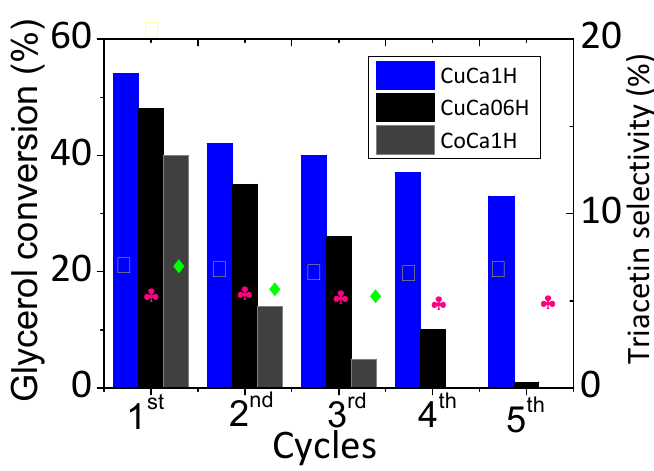
Figure 6. Recyclability studies over the most active catalysts. Reaction conditions: 75 mg of catalyst, glycerol to acetic acid molar ratios kept constant at 0.25. The reaction temperature was kept at 80 °C. The symbols ( (cid:0) ), ( ), and ( ) indicate the triacetin selectivities values for CuCa1H, CuCa06H, and CoCa1H catalysts, respectively.